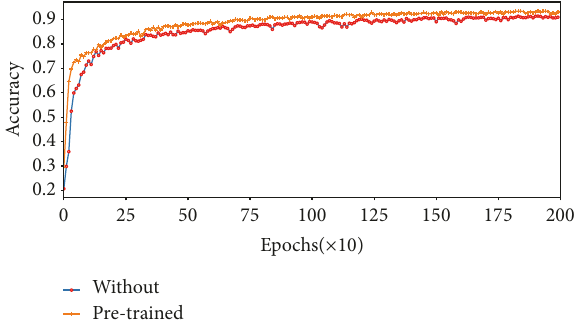
Figure 8: Comparison of training process between pretrained and without pretraining.